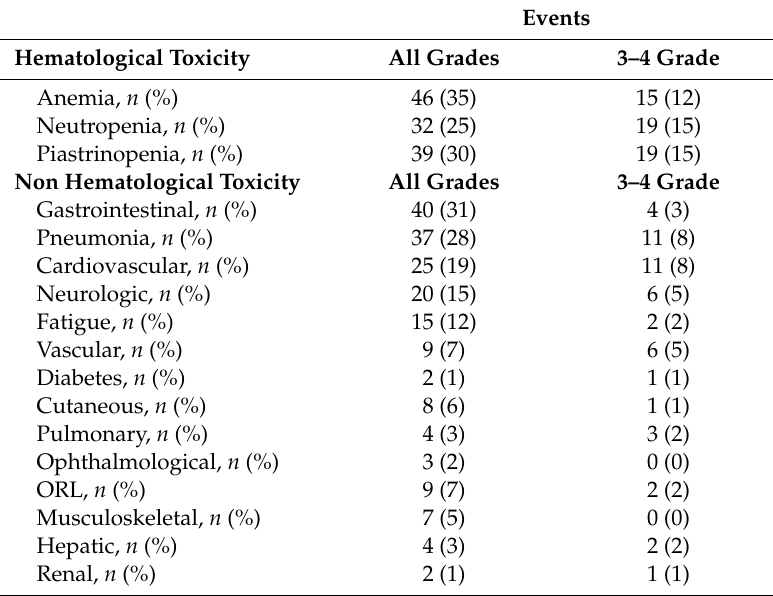
Table 3. Hematological and non-hematological toxicities in real-life KRd.